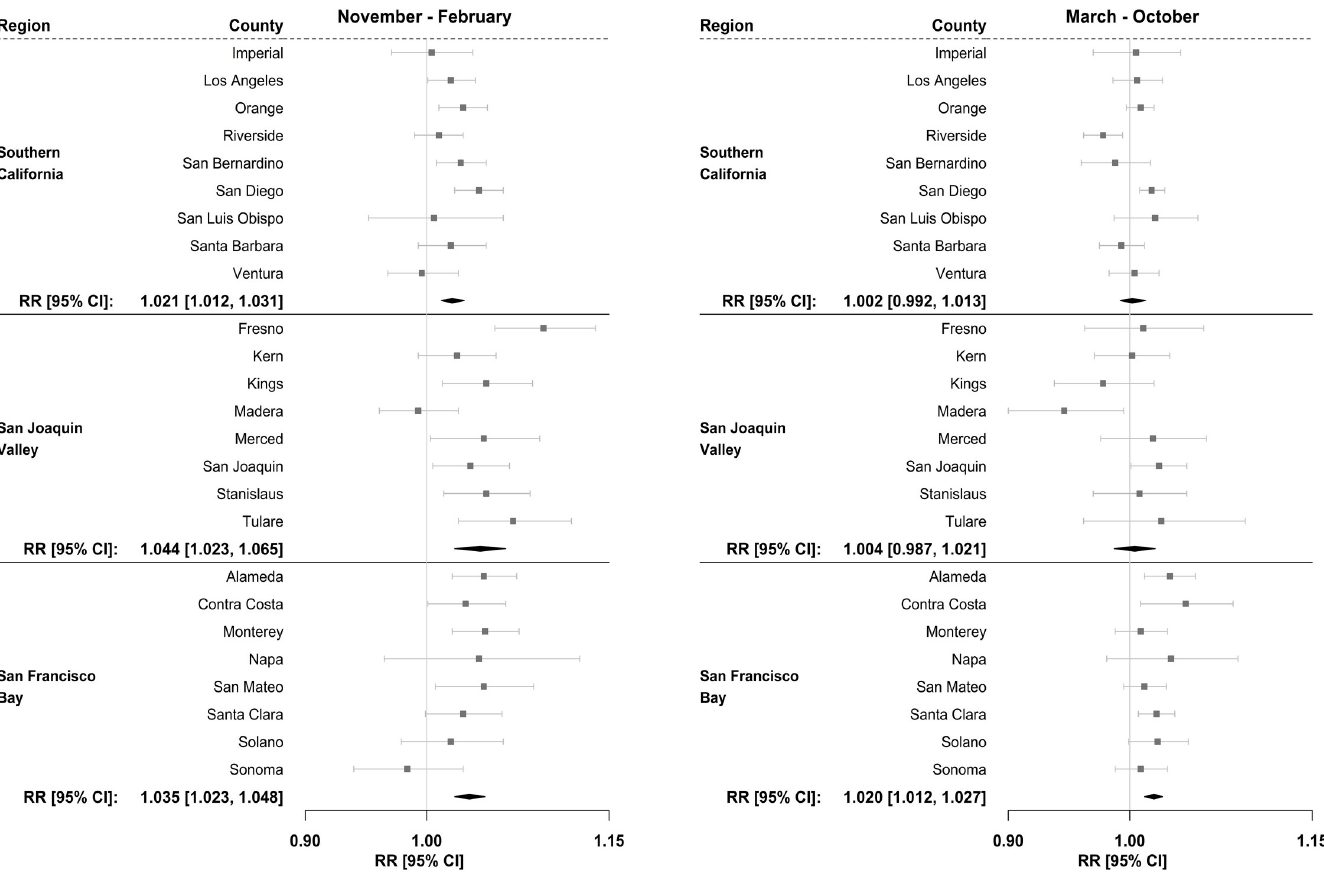
Fig 3. Relative risks of respiratory ED visits for inter-quartile change in AQI values during the cooler months (November to February) versus the warmer months (March to October) from 2012–2014, by county and region. Associations are shown for a four-day moving average of lag days 0 through 3. Abbreviations: AQI, air quality index; CI, confidence interval; RR, relative